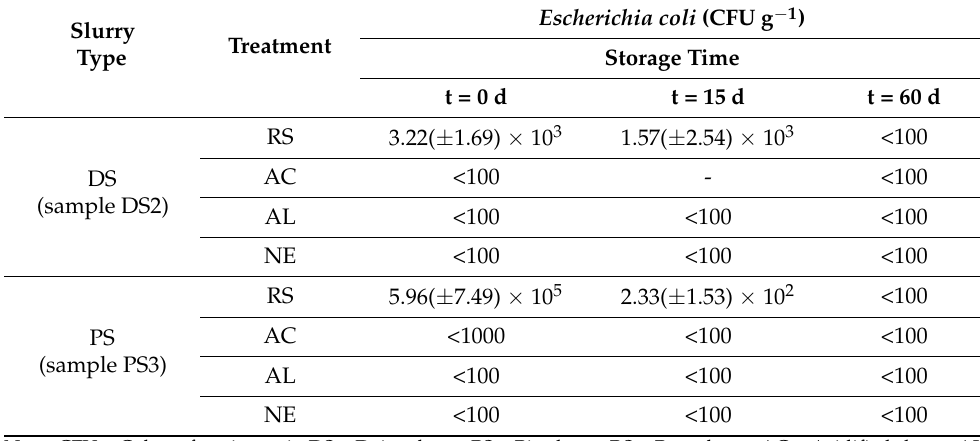
Table 4. E. coli (CFU g − 1 ) in raw and treated dairy and pig slurry samples (DS and PS), at the beginning of the storage test (t = 0 d) and after 15 and 60 days (t = 15 d; t = 60 d) (Mean, n = 3). Slurry samples were acidified to pH 5.0 (AC), alkalinized to pH 9.5 (AL), and a combined treatment alkalinization/neutralization (NE) was also tested.